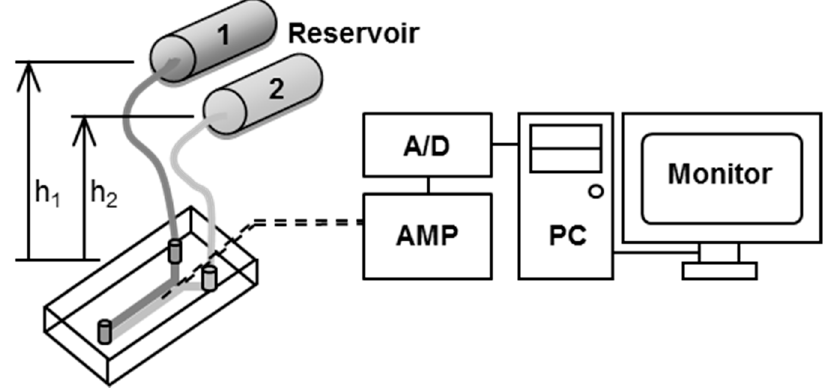
Figure 5. Schematics of the measurement system. Reservoir 1, sample solution; Reservoir 2, BLS. The h 1 and h 2 are the heights of the reservoirs.